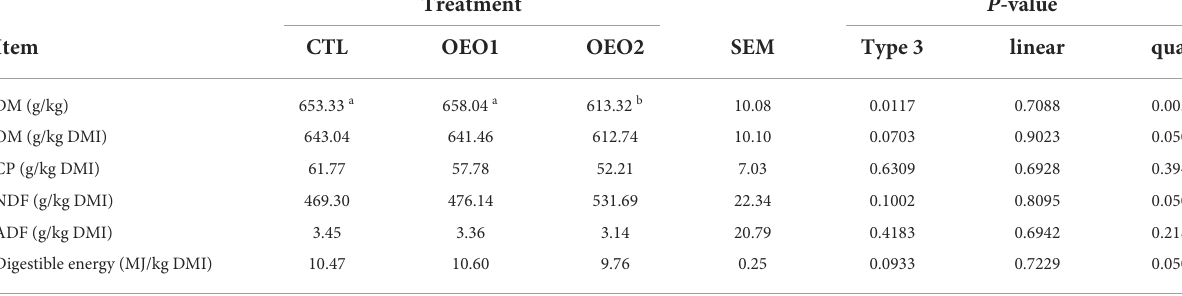
TABLE 7 Effect of orange essential oil (OEO) on the apparent total tract digestibility of heifers ( n = 6). Treatment P -value